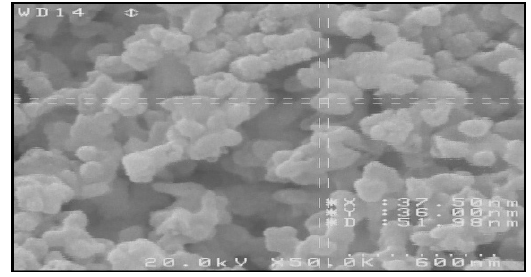
Fig. 6. SEM photographs of Co produced by calcination of precursor 1 at 550°C.